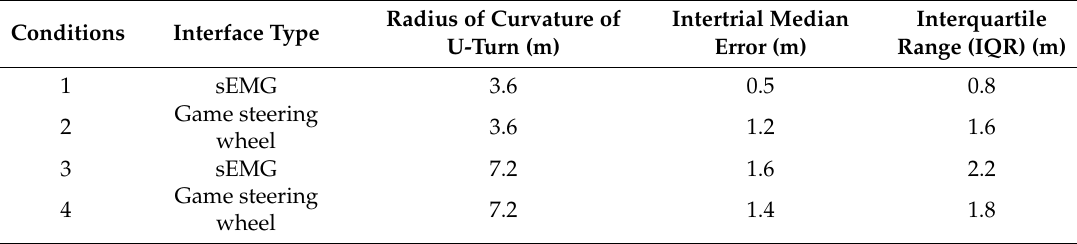
Table 2. Summary of results from driving simulator